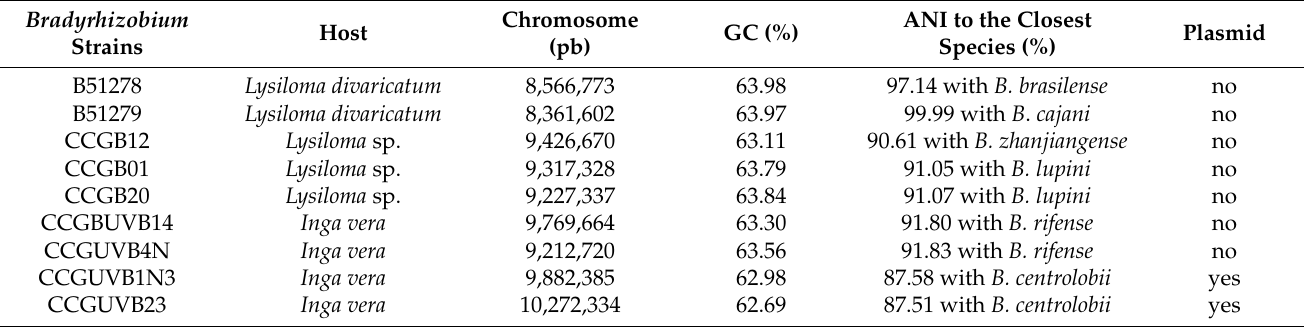
Table 1. Features of Bradyrhizobium sequenced